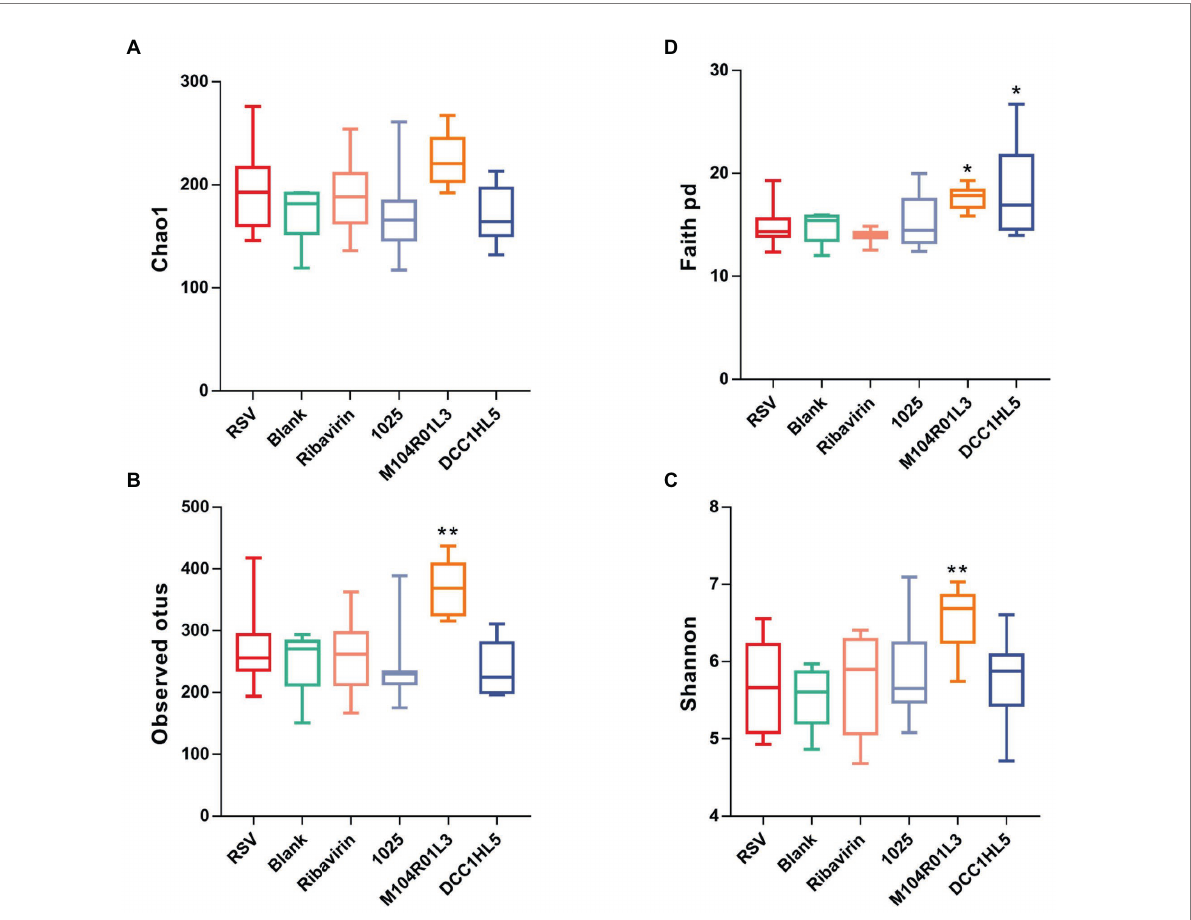
FIGURE 4 Impact of three Lactobacillus mucosae strains on the alpha-diversity of the gut microbiota. (A) Chao1, (B) observed operational taxonomic units (OTUs), (C) Shannon, and (D) Faith’s phylogenetic diversity indices. ( n = 8; * p < 0.05, ** p < 0.01 vs. RSV group). Differences were compared using one- way ANOVA, followed by Fisher’s LSD test. p values were adjusted using a false discovery rate. Blank, not infected with RSV. RSV, infected with respiratory syncytial virus and